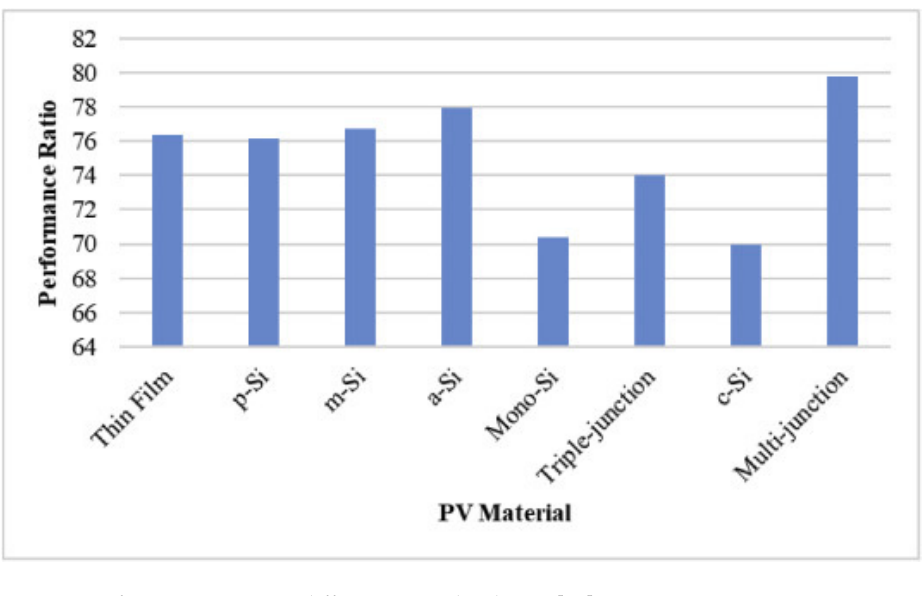
Figure 6. Performance ratio vs. different PV technologies [67].